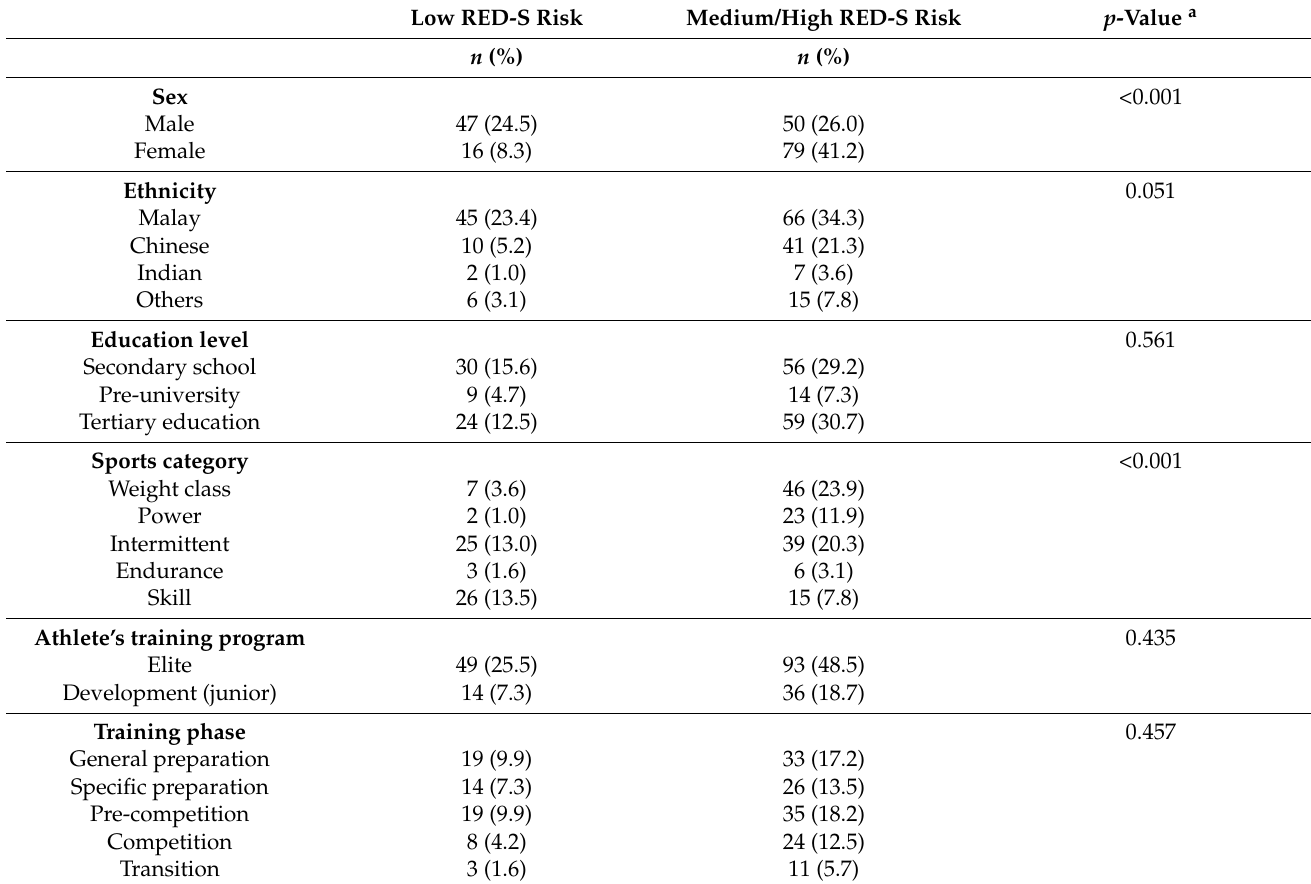
Table 2. Prevalence of RED-S according to sociodemographic